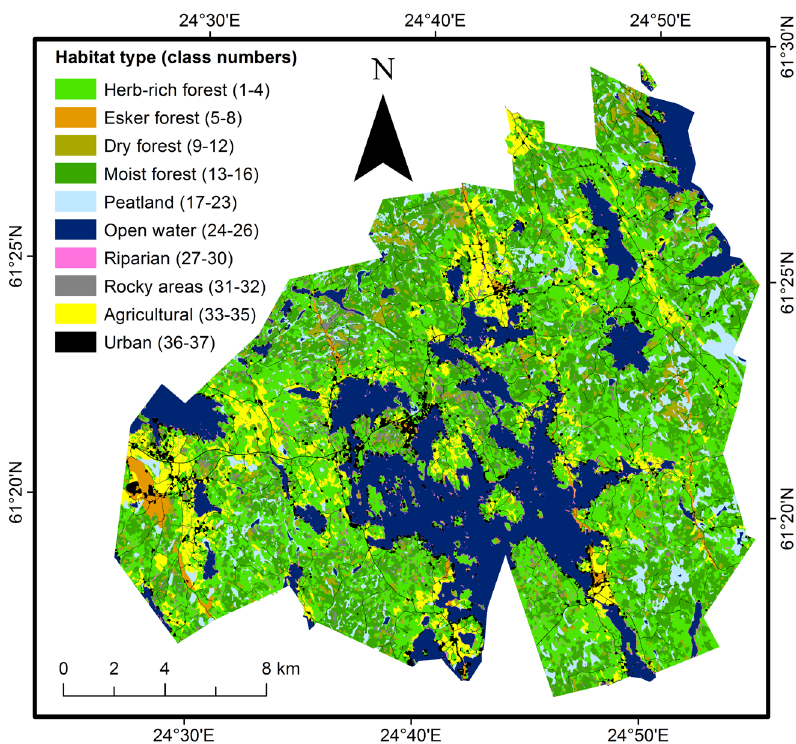
Figure 1: A simplified habitat type classification of the study area located in southern Finland. Habitat types are classified using classification alternative 1. Numbers in parentheses refer to habitat type class numbers that are explained in